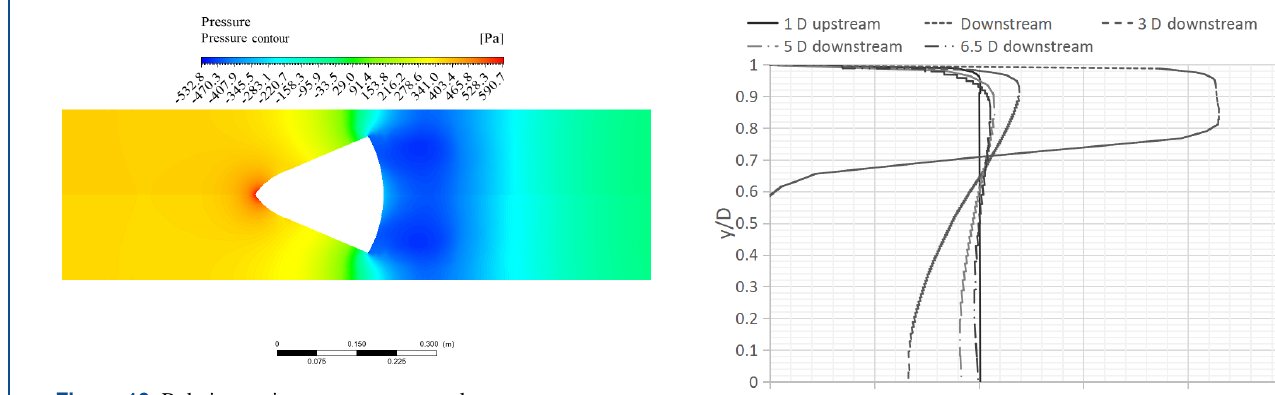
Figure 19. Relative static pressure contour plot.